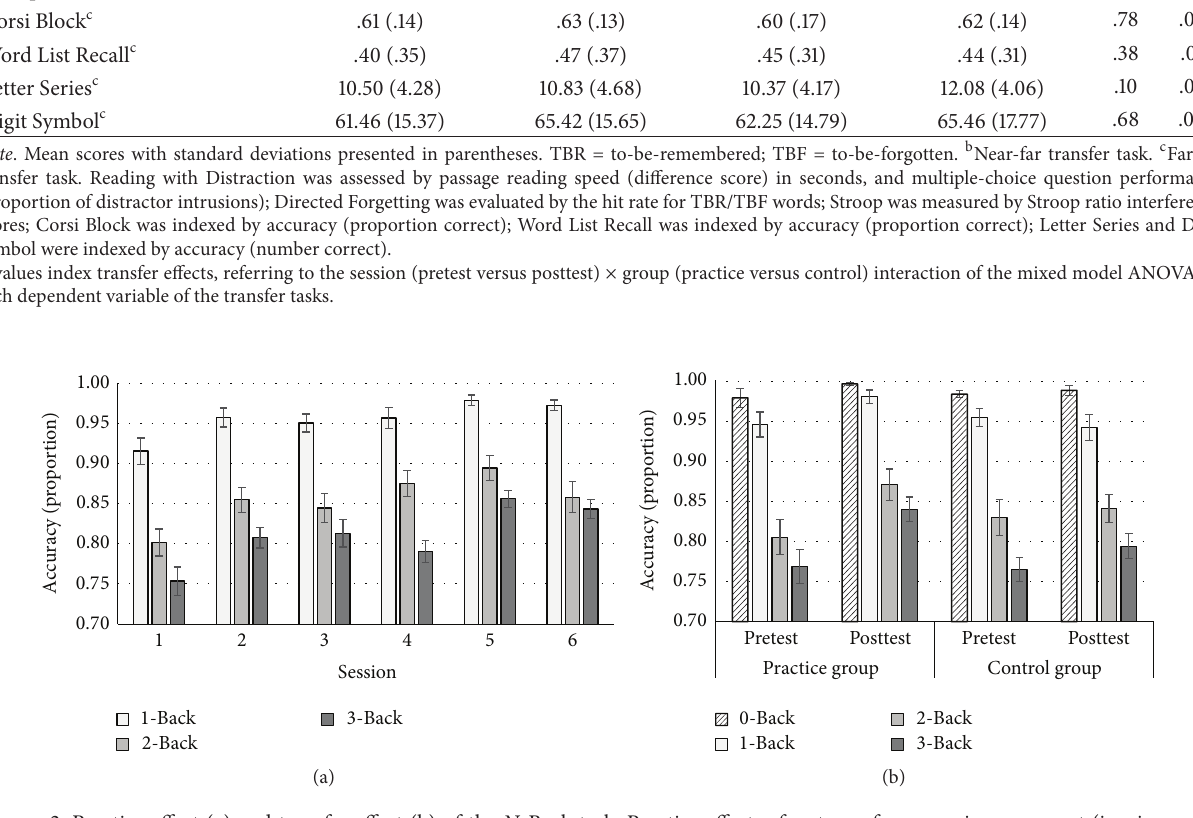
Figure 2: Practice effect (a) and transfer effect (b) of the N -Back task. Practice effect refers to performance improvement (i.e., increased accuracy) across six practice sessions. Transfer effect was indexed by the performance improvement from pretest to posttest in the practice group, but not the control group. Error bars represent the standard